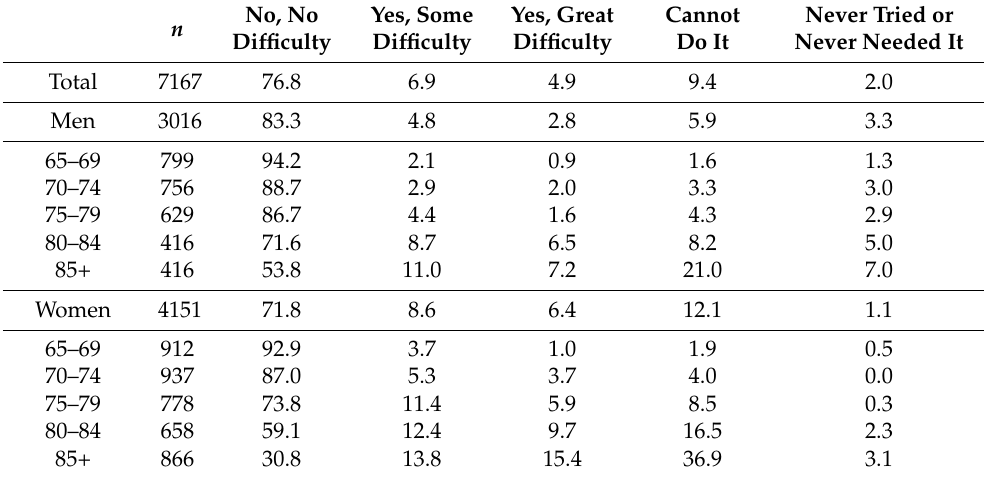
Table 2. Difficulty in making purchases, by sex and age group (number of observations and % by rows).